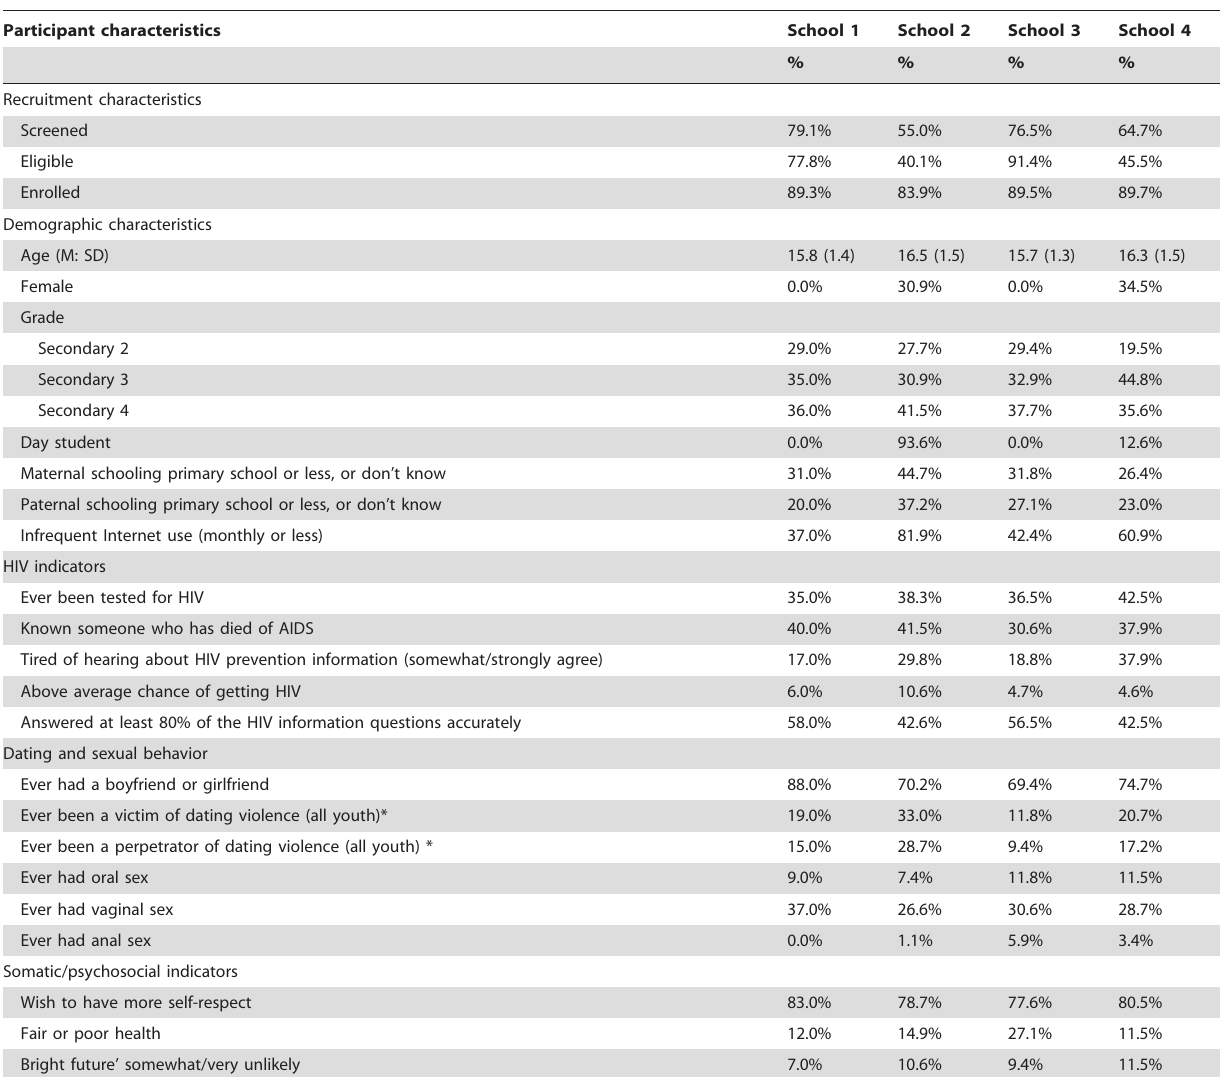
Table 1. Participant characteristics across the four schools